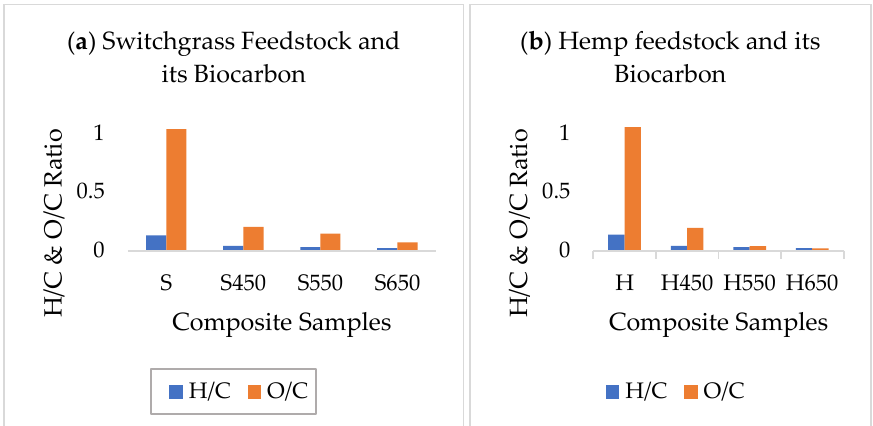
Figure 1. H/C and O/C trend in ( a ) switchgrass feedstock and its biochar, and ( b ) hemp feedstock and its biochar at different pyrolysis temperatures.